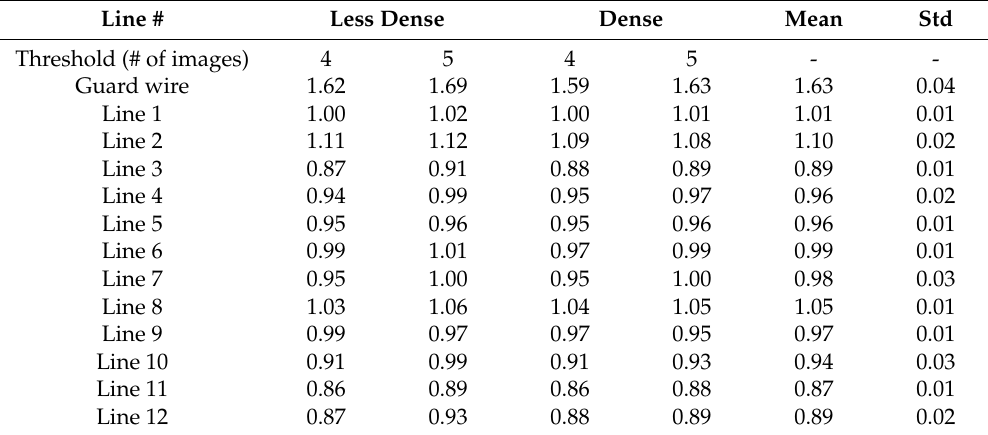
Table 5. Measured sags